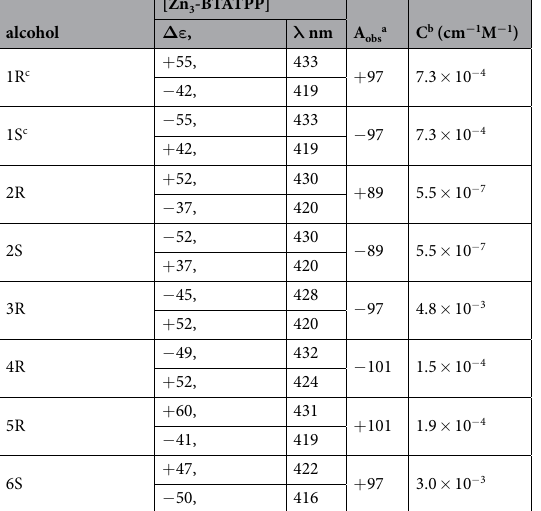
Fig. 3A. The carbonyl oxygens form hydrogen bonds with the coordinated OH, the corresponding O···O distances are 2.67 and 2.74 Å. The corresponding data are provided in Table S3. There are π - π interactions formed between the naphthyl rings of 2S and the linking phenyl ring. The centroid-centroid distances are 3.55 Å and 3.72 Å, the dihedral angles are 2.0° and 8.4°, respectively. The two guests fit the two “spaces” surrounded by three porphyrin moieties to form a “sandwich” like structure. As expected, 1-(1-naphthyl)ethanol is bulkier than 1-phenylethanol, which makes it match the “space” better, and also causes other interactions between hosts and guests. Besides coordination interactions, π - π interactions